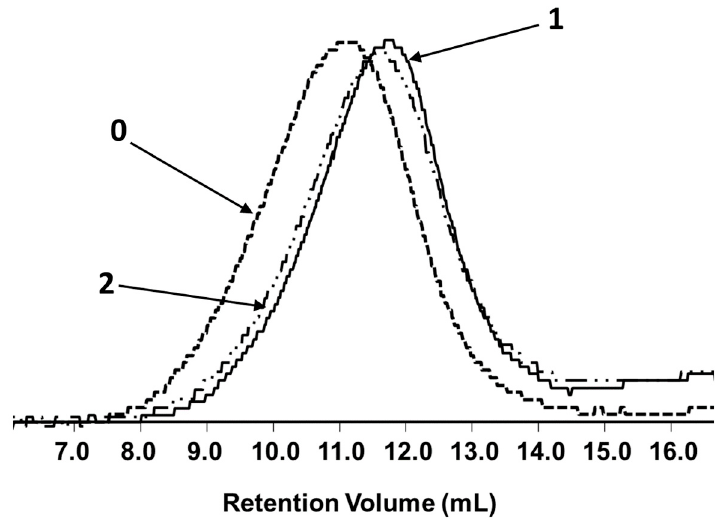
Figure 1. Overlay of selected GPC elugrams of pure P(3HB- co -4HB) before (0) and after processing (1) as well as the P(3HB- co -4HB) matrix with 30% cork (2).